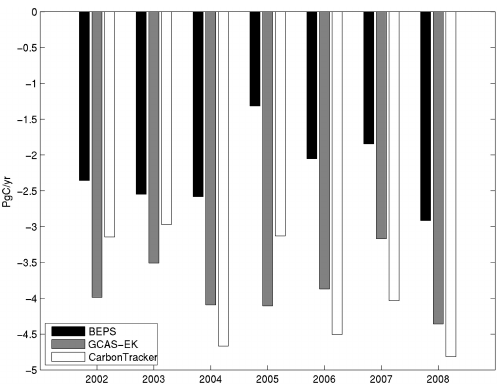
Figure 9. Comparison of interannual variations of global carbon budgets from 2002 to 2008 by three products: BEPS, GCAS-EK and CarbonTracker 2011.